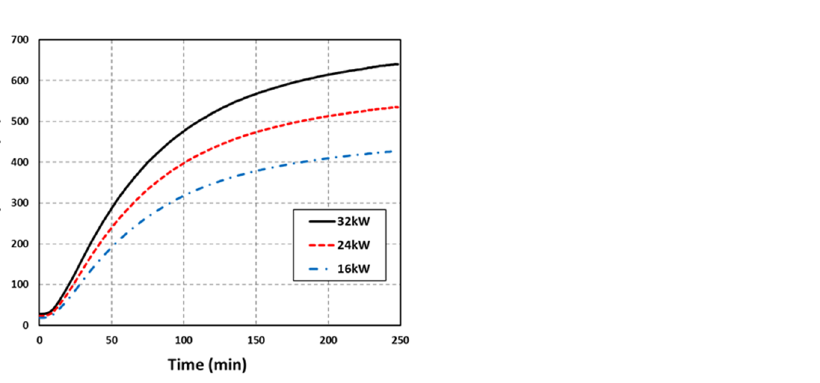
Figure 4. Monitored temperature preheated for indirect-heated microwave thermal desorption.